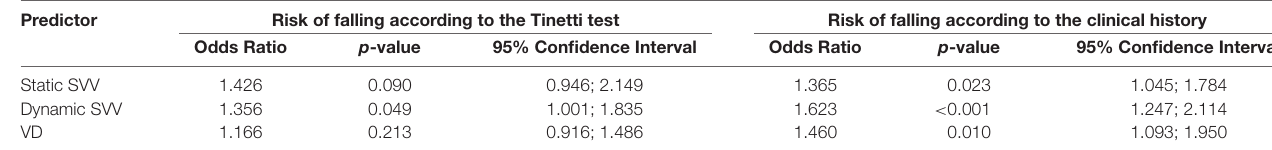
the true vertical in the roll vection test was 6.6 degrees for the faller group and 3.6 degrees for the non-faller group (Lord and Webster, 1990). Barr et al. also evaluated a link between VD deviation from vertical in the roll vection test than those who VD was measured irrespective of static SVV. Therefore, the and the results are in line with ours. Using static and dynamic SVV measurements may be of practical utility to help guide the type of rehabilitation required for a given individual,